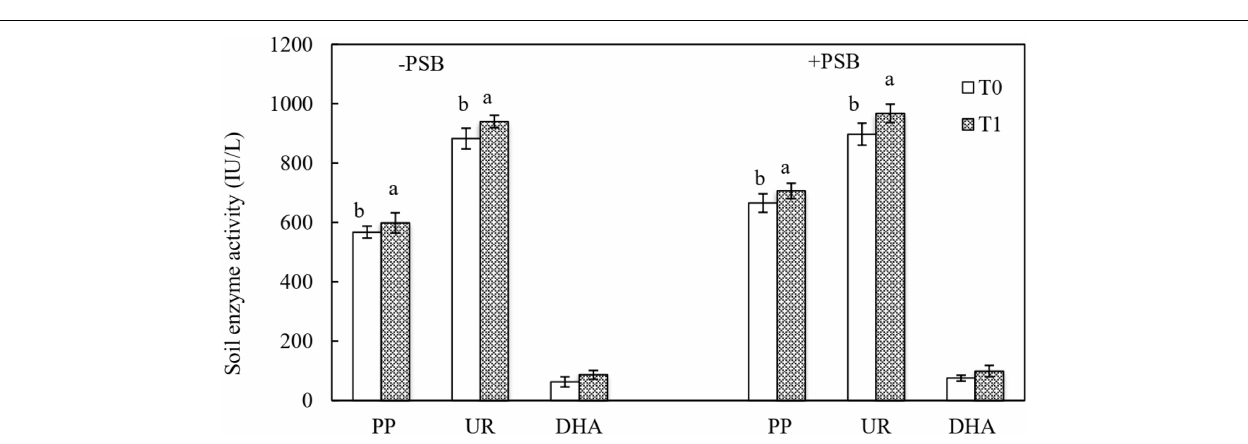
FIGURE 4 | Effects of rock phosphate (RP) and phosphate-solubilizing bacteria (PSB) on soil alkaline phosphomonoesterases (PP), urease (UR), and dehydrogenase (DHA) enzyme activities (IU/L). Treatments: T0, without RP; T1, with RP; − PSB, without PSB; +PSB, with PSB. Values are the means of three replicates. Error bars represent ± standard deviation. Values sharing a common letter within the column are not significant at P < 0 . 05.